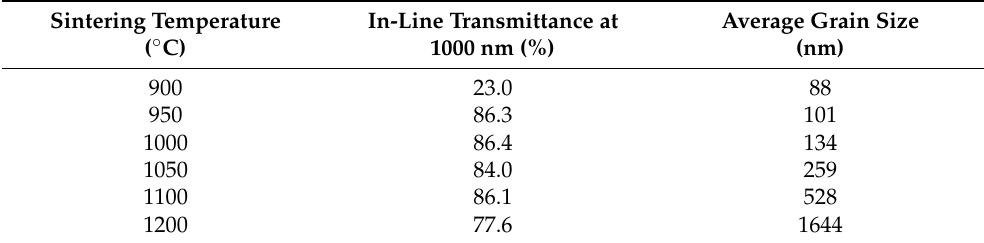
Figure 4. ( a ) Photographs of FAP ceramics sintered at various temperatures. The ceramics were placed 10 mm above the text in each case. ( b ) In-line transmittance spectra of the FAP ceramics. Table 1. In-line transmittance at the wavelength of 1000 nm and average grain sizes of FAP ceramics prepared using different sintering temperatures.